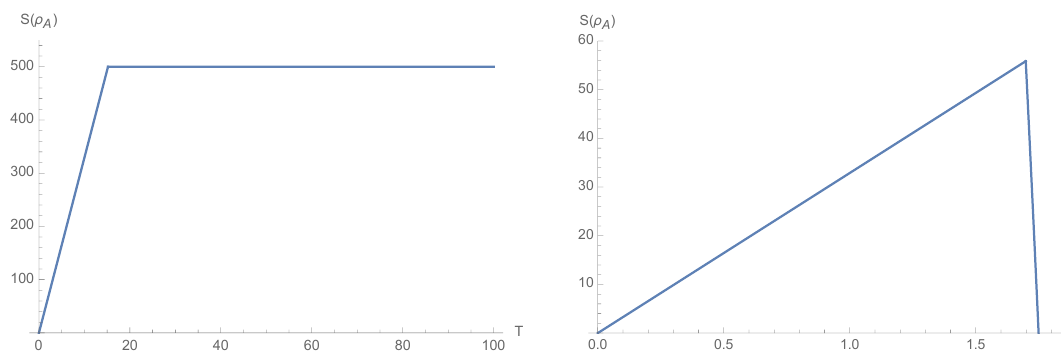
Figure 8 . Left : plots of the entanglement entropy (2.5) of the AdS JT gravity case as a function of the entanglement temperature T = 1 /β . We set the parameters to be φ 0 ,A = 300 , φ 0 ,B = 200 , c = 10 , 4 G N = 1 . Right : similar Plots for flat CGHS model case as a function of T = 1 /β . We set the parameters to be φ 0 ,A = 300 , φ 0 ,B = 200 , | Λ | = 100 , c = 10 , 4 G N = 1